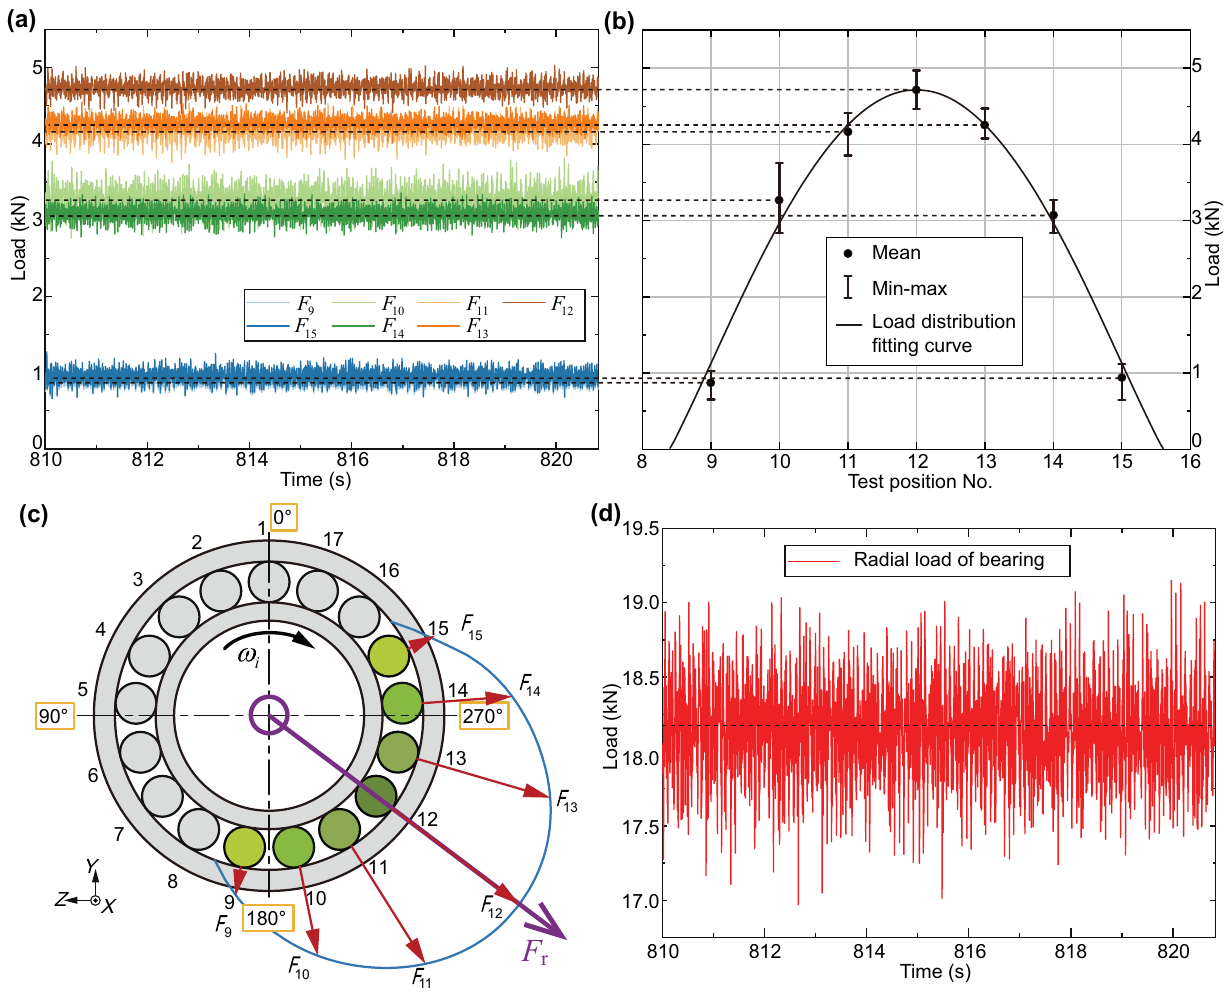
Fig. 8 Determination of the time history of the measured bearing load (test condition: input speed 1550 rpm and input torque 3000 N·m): a typical load time histories of measured nonzero distributed loads; b measured load distribution within the bearing; c direction of the distrib- uted and total radial load; d measured real-time bearing